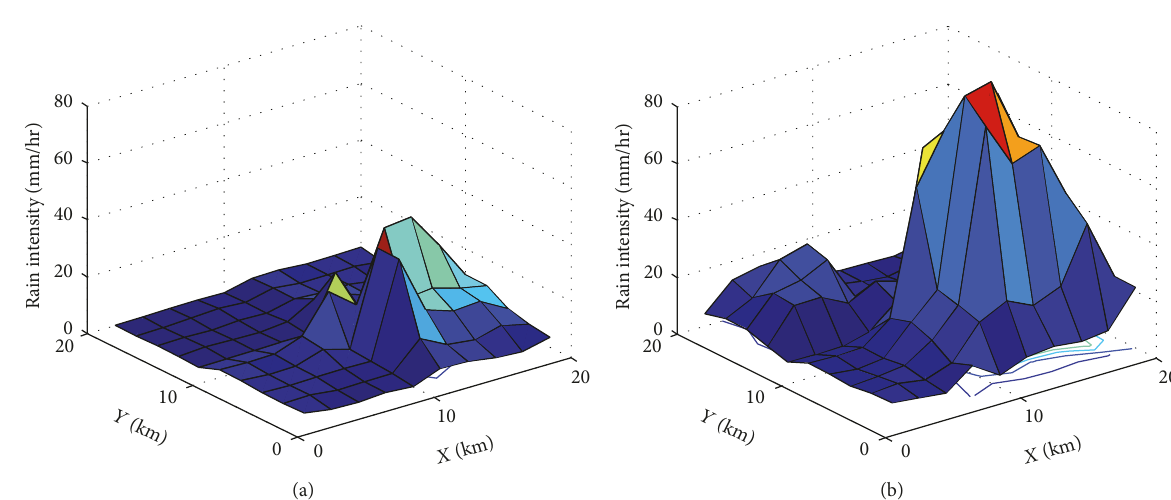
Figure 9: Rainfall intensity: (a) uncorrected; (b)